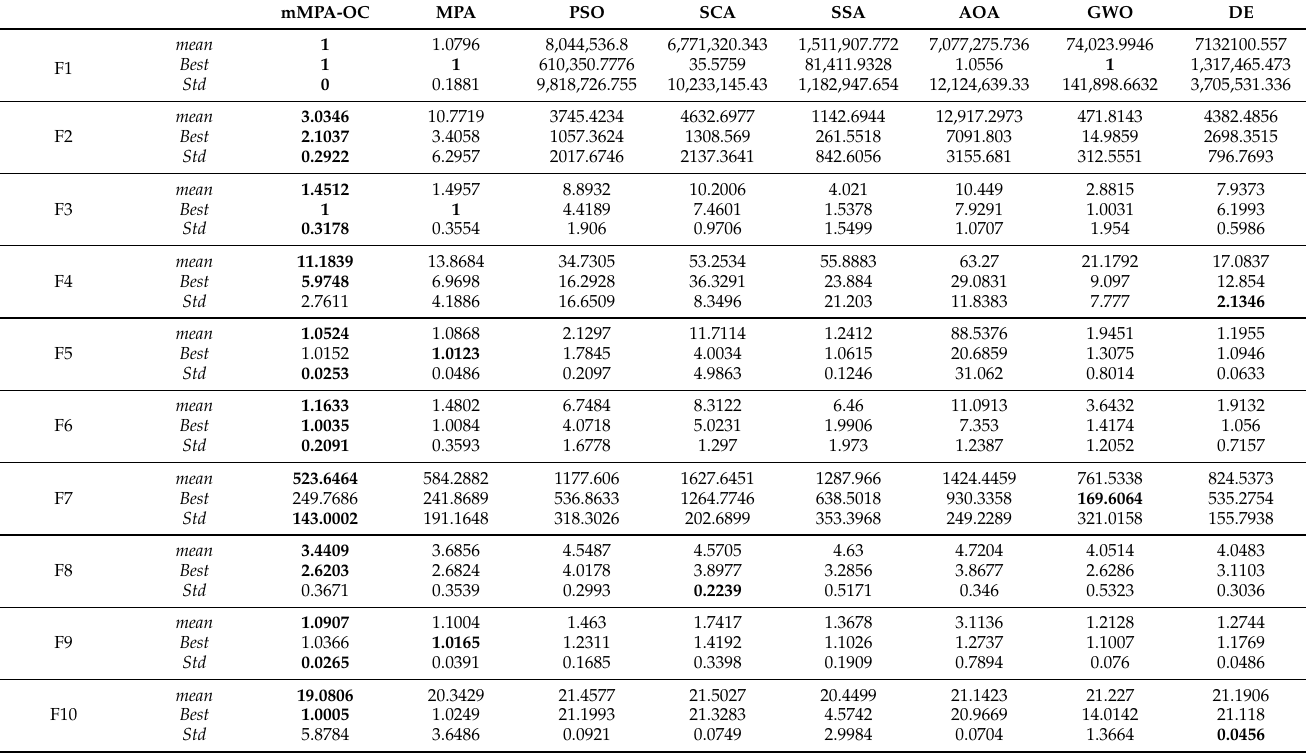
Table 16. Comparison of experimental results in